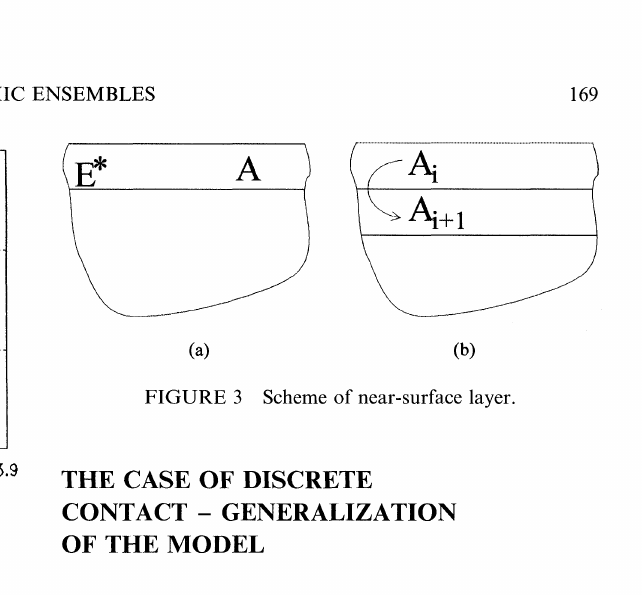
FIGURE 2 The dependence AI(#) for logistic map.